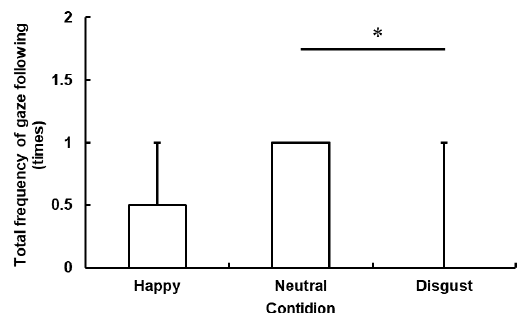
Figure 3. Total frequency of gaze following. Total frequency of gaze following during two gaze- emotional cue presentations per trial of each experimental condition. The maximum value was 2 in each experimental condition because the experimenter presented gaze shift two times per trial. The median in each condition was 0 in the Happy condition, 1 in the Neutral condition, and 0 in the Disgust condition (* p <